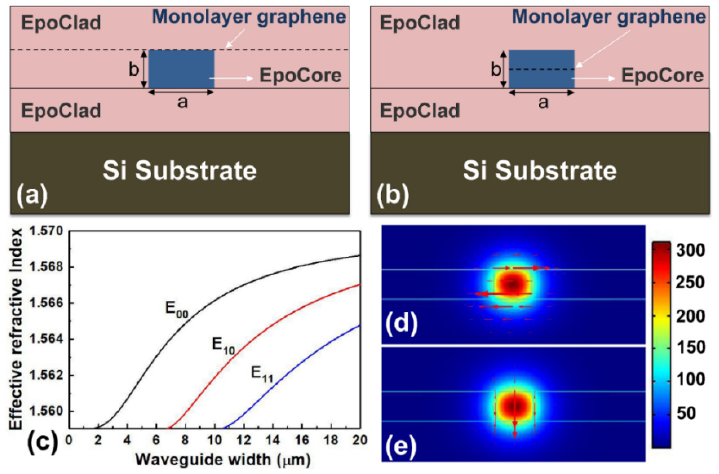
Figure 1. Schematic diagram of the polarizer with the monolayer graphene film placed ( a ) on the surface of core layer and ( b ) buried in the center of core layer. ( c ) Relations between effective indices N eff of the waveguide and core width. The simulated intensity patterns of the fundamental mode with the optimized core dimension for ( d ) TE and ( e ) TM polarizations, respectively.